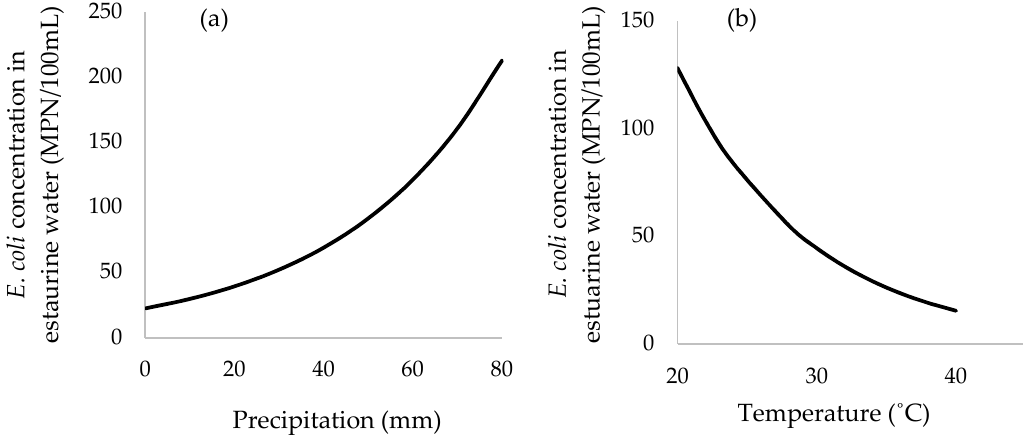
Figure 5. Predicted average concentration of EC (MPN/100 mL of estuarine water) as a function of: ( a ) average precipitation over 7 days; ( b ) ambient air temperature